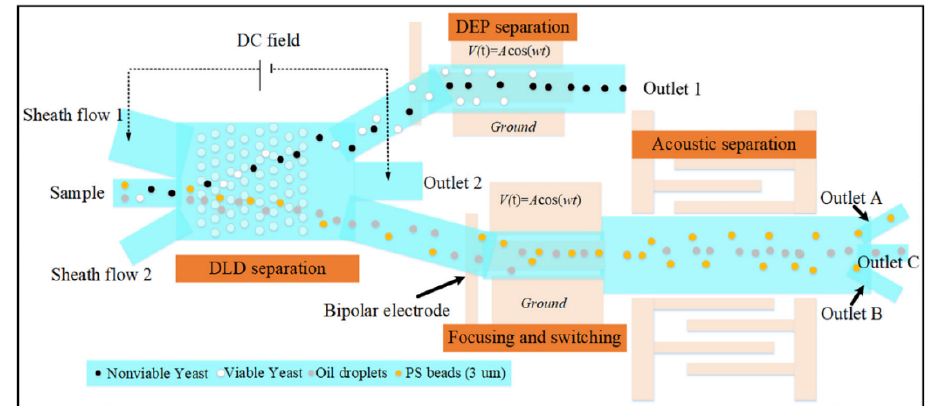
Figure 9. A cascade system to schematize integrated active type particle separation modules [103], Copyright 2021, ACS Publications.